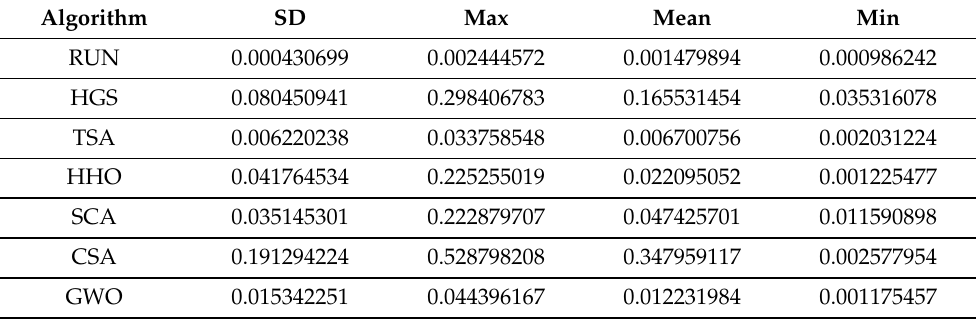
Table 6. SDSCM statistical